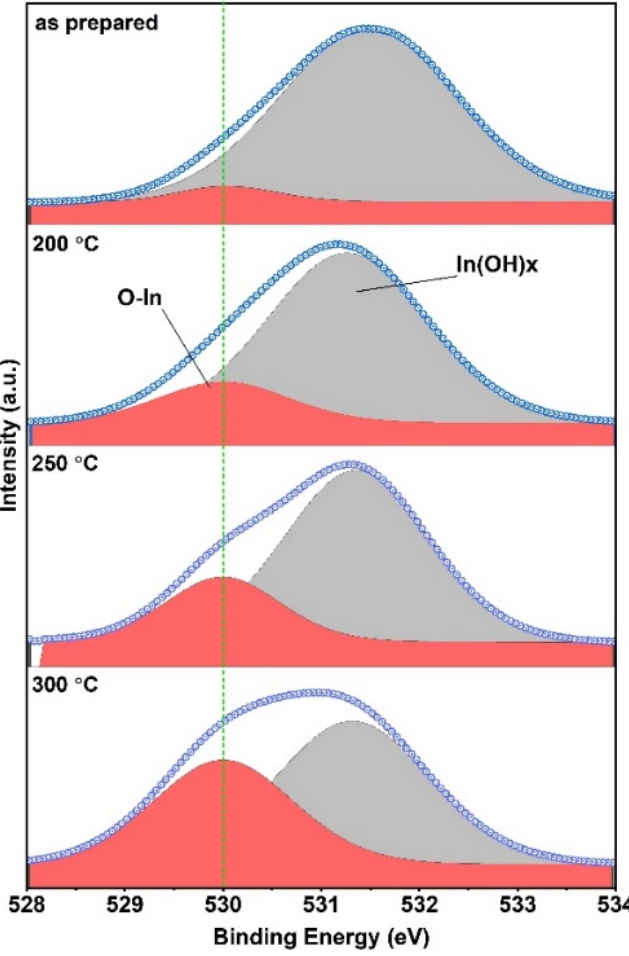
Figure 8. O 1 s XPS core level spectra of the surface-cleaned In 2 O 3 :H films, as prepared and at annealing temperatures of 200, 250, and 300 °C. Al K α radiation was used as an excitation source.